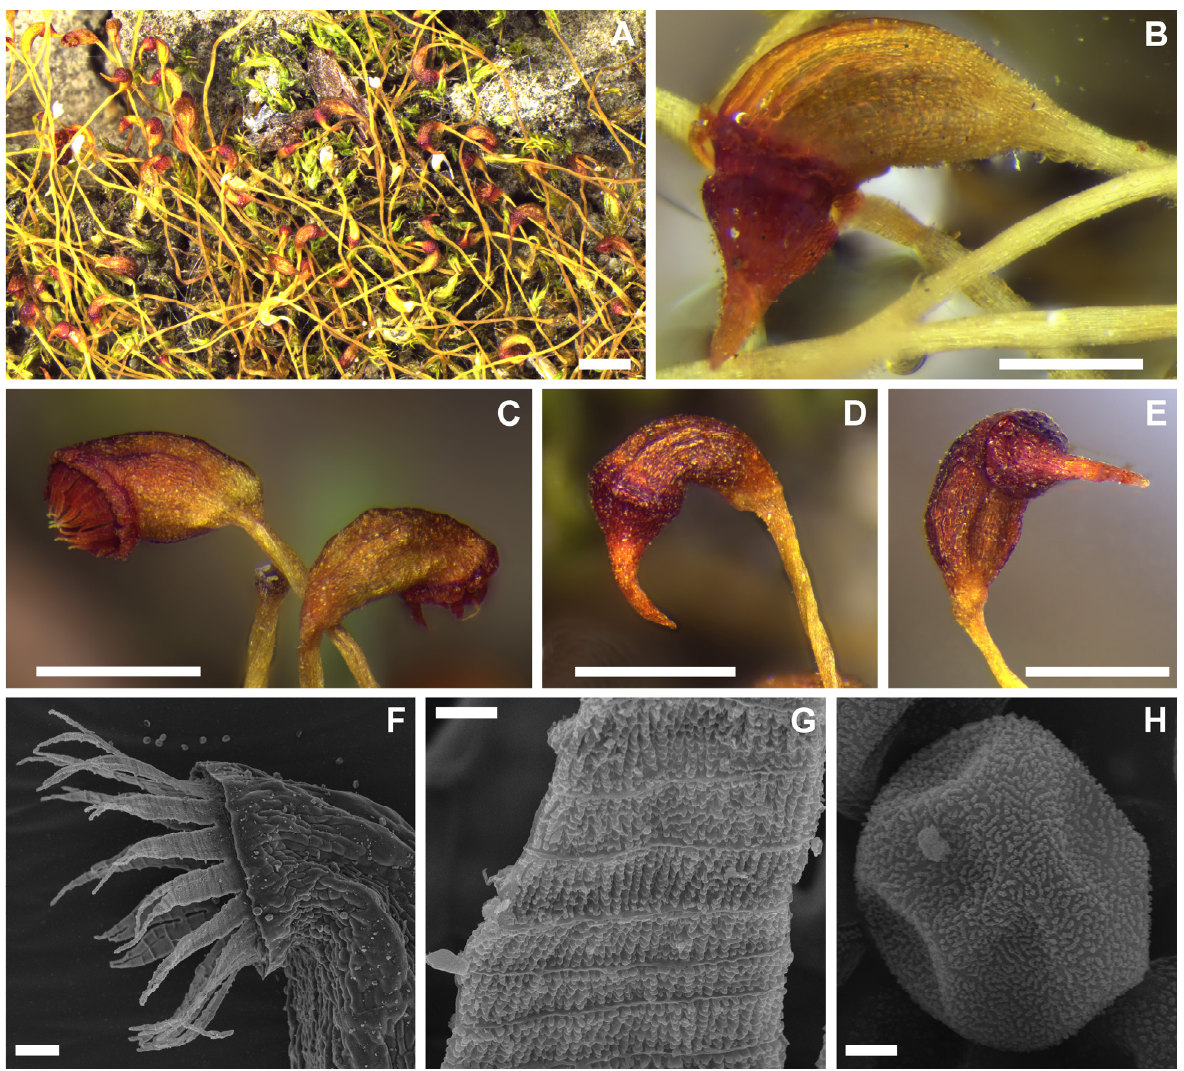
Figure 2. Sporophytes and peristome of Dicranella staphylina (from North Siberia, MW9117945, FDt107) . ( A ) fragment of specimen with sporophytes, ( B ) wet opening capsule with dehiscent annulus , ( C – E ) dry capsules, ( F ) SEM image of peristome, ( G ) outer surface of the lower part of segment, ( H ) spore. Scale bars: 1 mm for ( A ); 0.5 mm for ( B – E ); 100 μ m for ( F ); 10 μ m for ( G ); 2 μ m for ( H ).